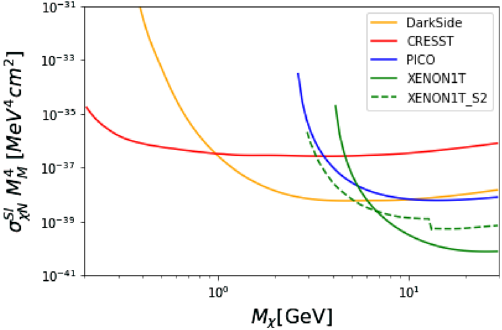
Fig. 9 Limits on the spin-independent DM nucleon point-like cross section for a light mediator, M M = 10 MeV, using the micrOMEGAs recast of XENON1T, DarkSide-50, PICO-60 and CRESST-III. The limit derived by XENON1T using a ionization-only analysis is also displayed, XENON1T-S2 [9]